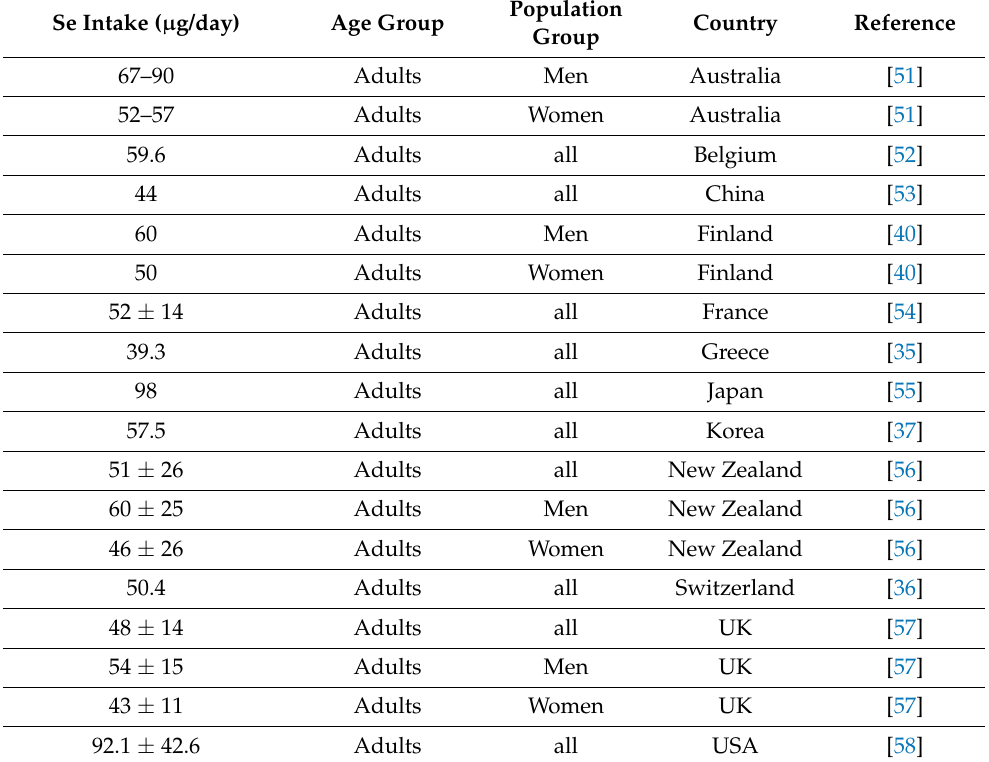
Table 2. Selenium daily intake from selected